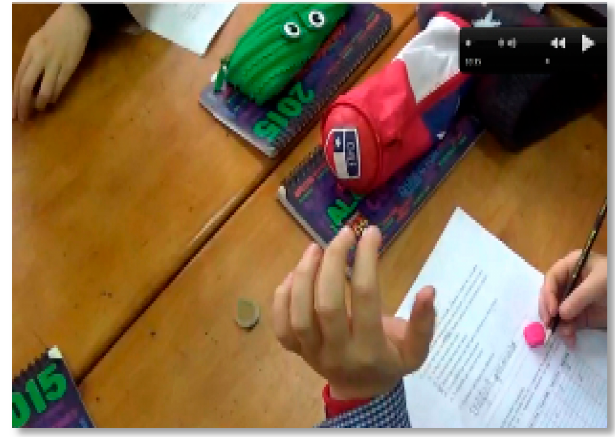
Figure 8. Image capture of 4th grade class.